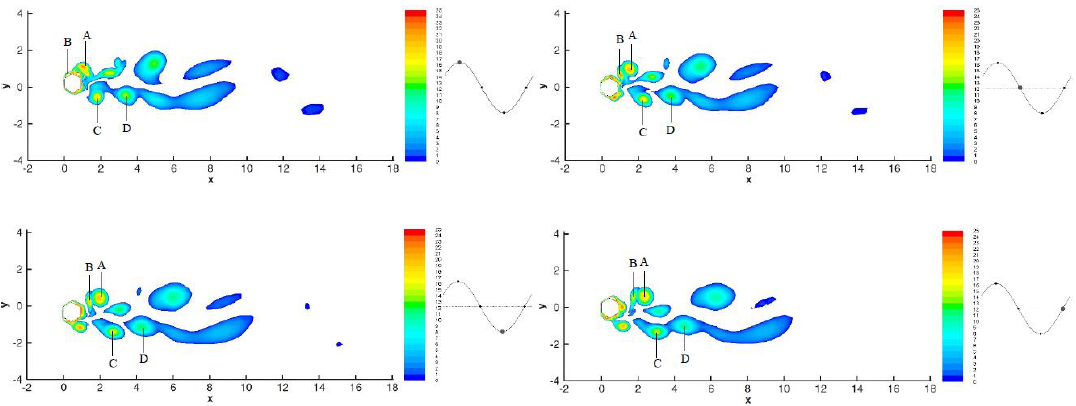
Figure 10. Vorticity contours at four instants in a vibration period of the face-oriented hexagonal cylinder at V r = 2 at 83.23 < t* <